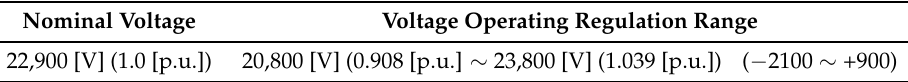
Table 2. Voltage Operating Regulation Range of Distribution System in South Korea.